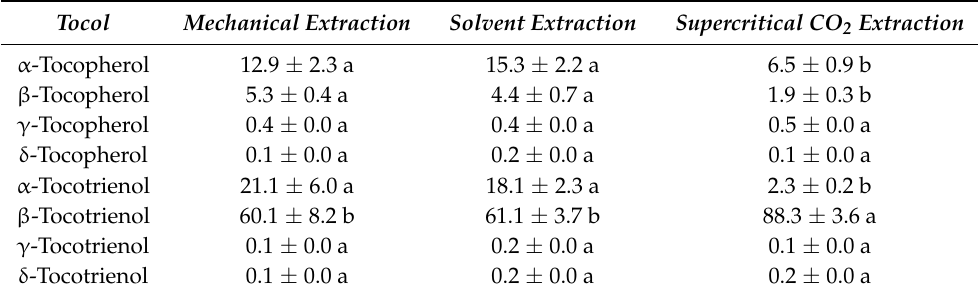
Table 4. Tocol composition (%) of WGO extracted with different technologies.